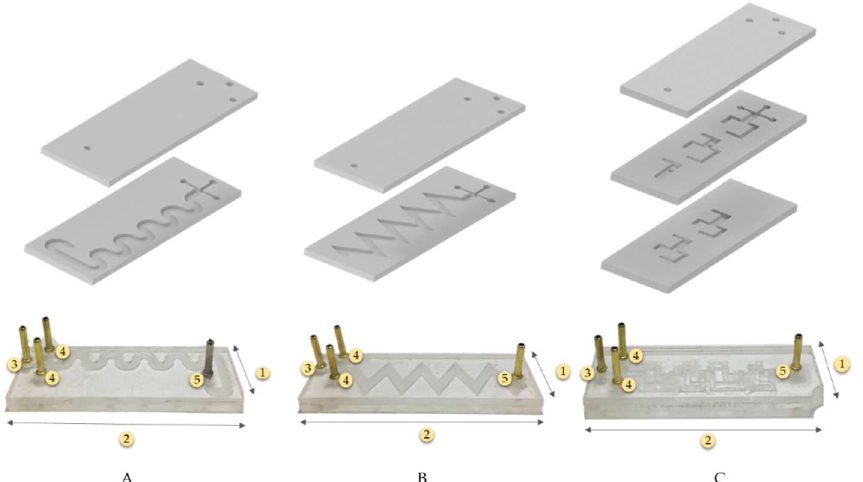
Figure 2. Microfluidic mixers assembly sketch. ( A ) Two layers of the serpentine − based mixer (SB), ( B ) two layers of the triangular − based mixer (TB), and ( C ) three layers of the 3D − based mixer (3DB). (1. Width: 25 mm, 2. Length: 75 mm, 3. NaOH solution Input, 4. Iron chloride mixed solution Input, 5.